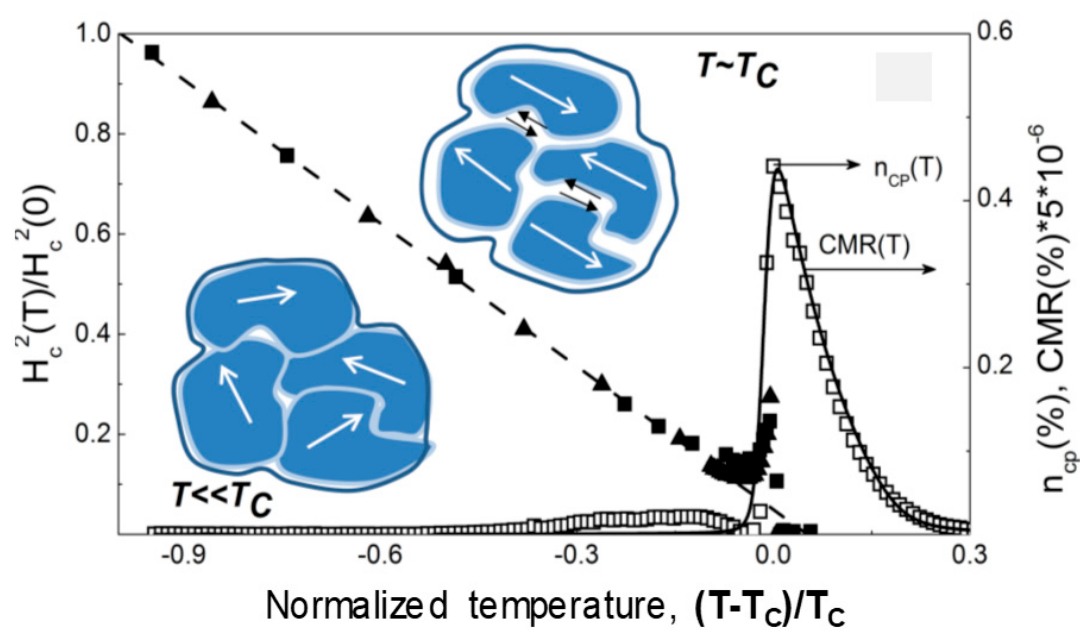
Figure 4. Normalized coercive field, H c (T)/H c (0) (left scale), concentration of correlated polarons, n CP in percent (open squares) and colossal magnetoresistance, CMR × 5 × 10 − 6 (line), in two (La 1 − y Pr y ) 0.7 Ca 0.3 MnO 3 (LPCMO)/MgO(100) films with different Pr-substitution (y = 0.375 and 0.4) as a function of the normalized temperature, (T − T C )/T C , because the films have different T C values, i.e., 195 K (y = 0.4) and 210 K (y = 0.375). Closed squares and triangles depict the H c (T) ~ T 1/2 behavior for films with Pr concentration y = 0.375 and 0.4, respectively. An anomalous increase in the coercive field close to T C indicates the enhancement of AFM coupling in the phase-separated state. "Reprinted figure with permission from [30] Copyright (2014) by the American Physical Society.